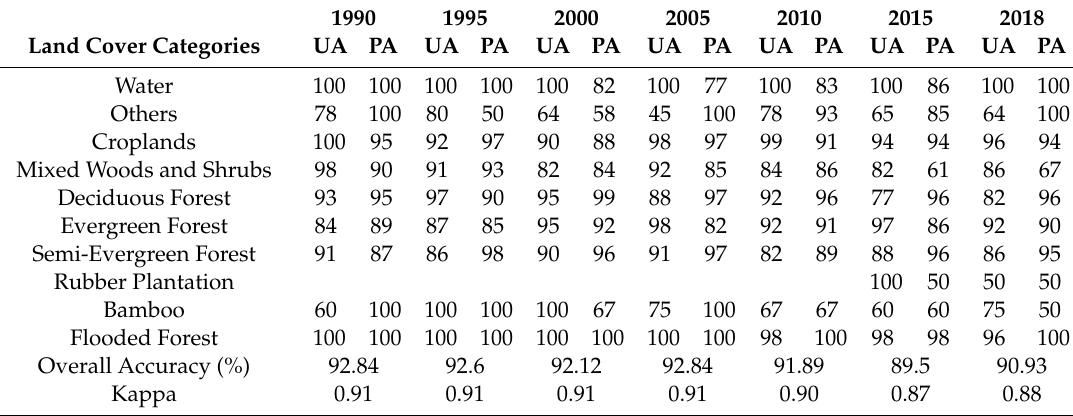
Table 5. Classification accuracy (%) for PBTC maps using Google Earth high-resolution imagery from 1990 to 2018.